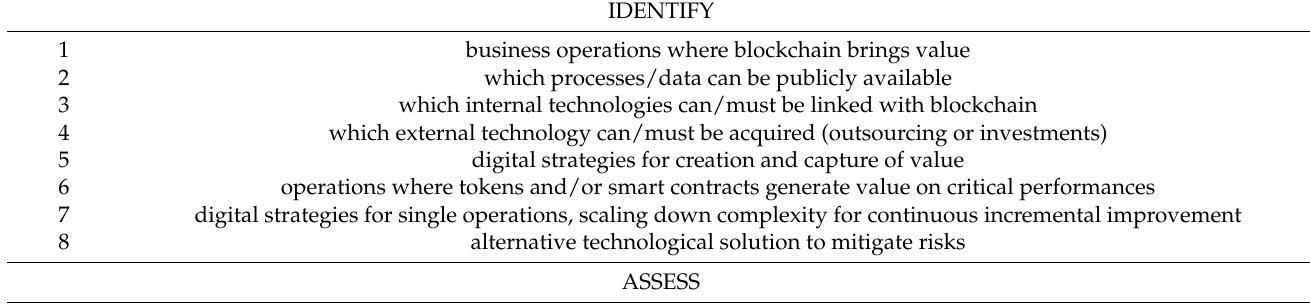
Table 7. Four steps framework for the evaluation and detection of relevant